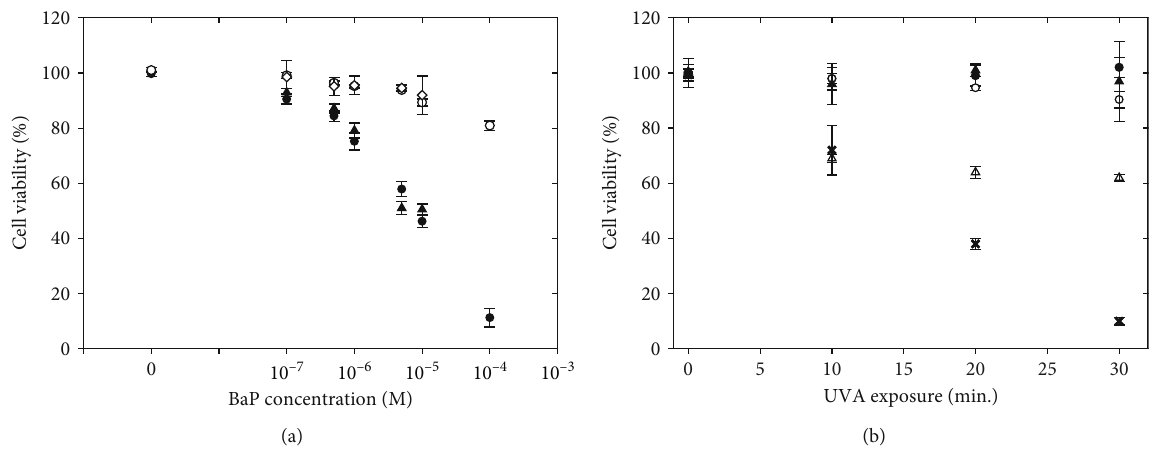
Figure 3: Loss of cell viability as the level of concurrent UVA and BaP exposure increases. (a) E ff ect of BaP concentration (10 − 7 to 10 − 4 ) mol/L with 30 min UVA exposure ( fi lled symbols) and without (open symbols). Data from 2 separate replicate experiments is included. (b) E ff ect of increasing UVA exposure ( 10 min = 2 : 1 J/cm 2 , 20 min = 4 : 2J/cm 2 , and 30 min = 6 : 3 J/cm 2 ) and increasing BaP concentration: media only ( ▲ ); 10 − 7 M ( ● ); 10 – 6 M (o); 10 − 5 M ( Δ ); 10 − 4 M (x). The data point at 10 − 4 M BaP, 10 min. UVA exposure was obtained from a di ff erent but equivalent set of experiments. UVA exposure times were at an intensity of 3.5mW/cm 2 . M: mol/L. Results were calculated and plotted as the mean and standard deviation (see Materials and